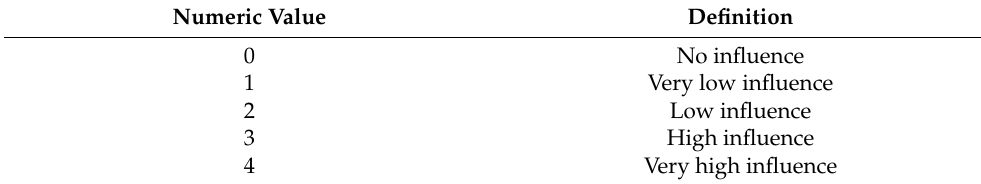
Table 1. DEMATEL comparison scale